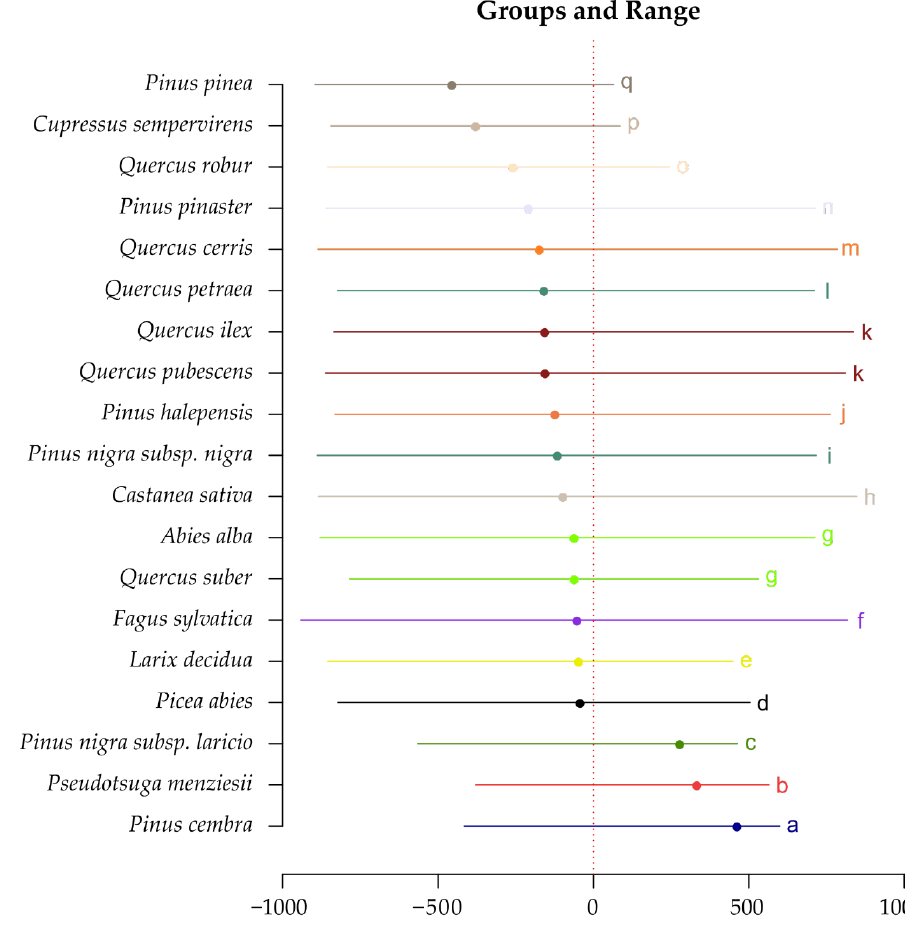
Figure 5. Potential absolute variation in suitability values of considered forest tree species. The only spatial distribution map realized with COSMO climate scenario was used for this analysis. The spatial variation was calculated using Tukey test. On the x -axis the potential variation in habitat suitability values is reported.